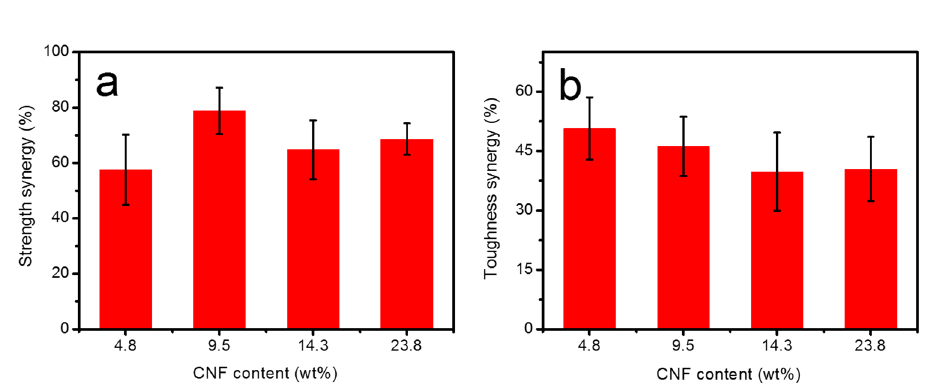
Figure 11. Synergy percentage of increases with CNF contents in P-GCP ternary artificial nacre nanocomposites: ( a ) strength and ( b ) toughness synergy percentage.